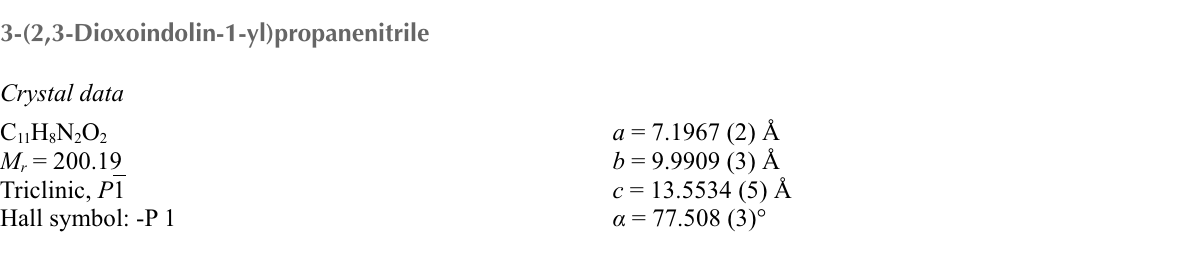
Figure 2 View showing the fitting of the two molecules in the asymmetric